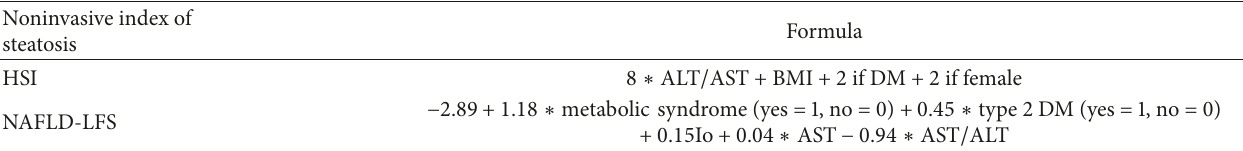
Table 1: Formulas for calculating noninvasive scores for steatosis.